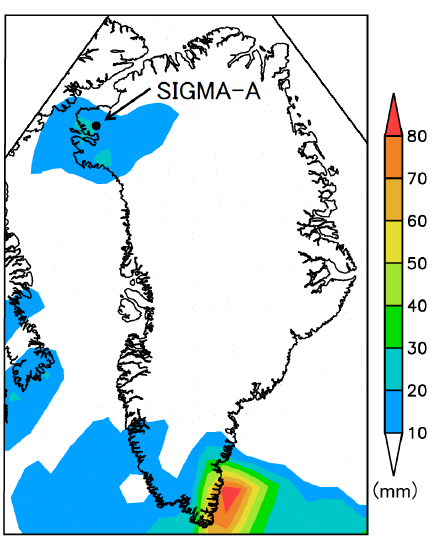
Figure 3. Accumulated precipitation from 00:00UTC on 10 July 2012 to 12:00UTC on 14 July 2012 obtained from the 3-hourly ERA-Interim reanalysis data. Black colored circle indicates the location of site SIGMA-A.